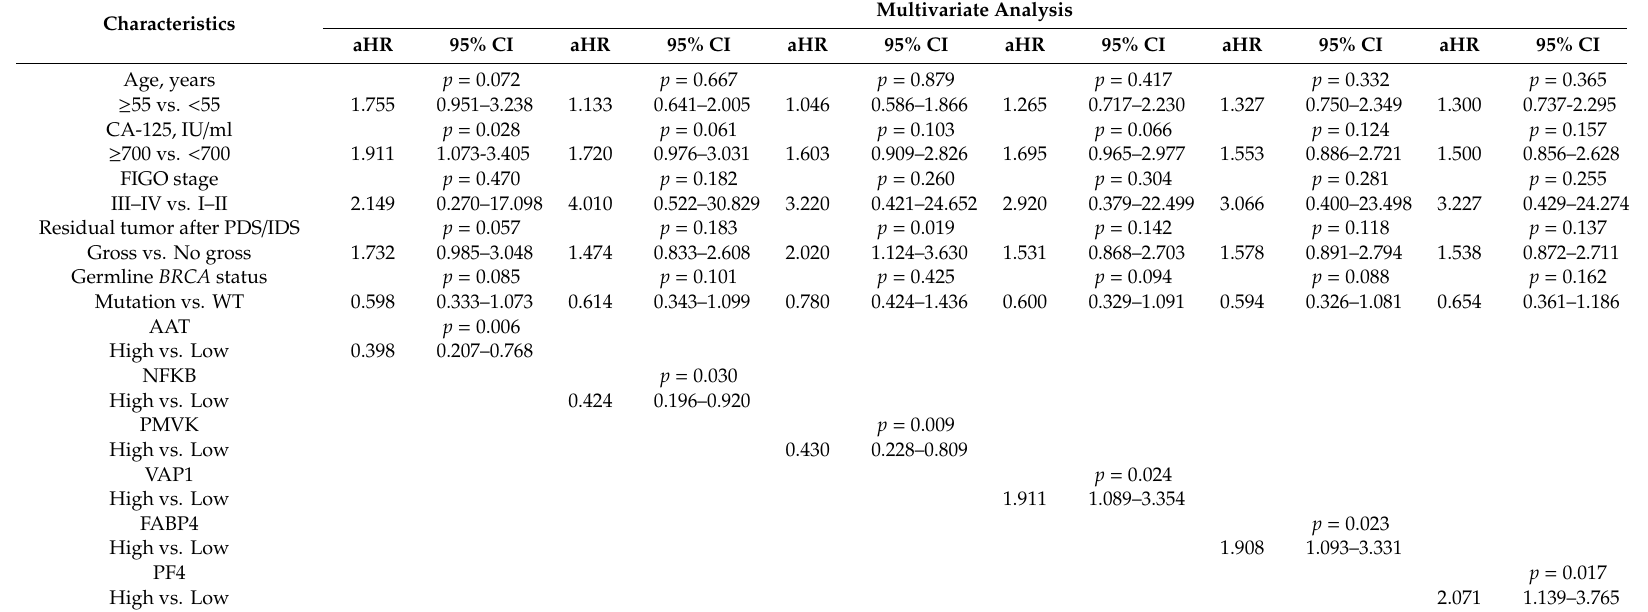
Table 2. Factors associated with progression-free